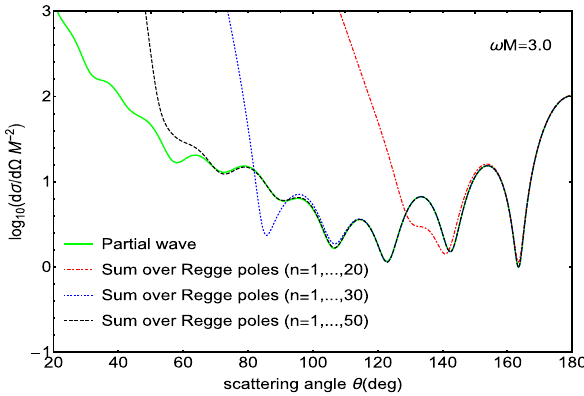
approximation for ω M = 3 . 0. The plot shows that summing over afew Reggepoles captures most of thefeatures of thethe